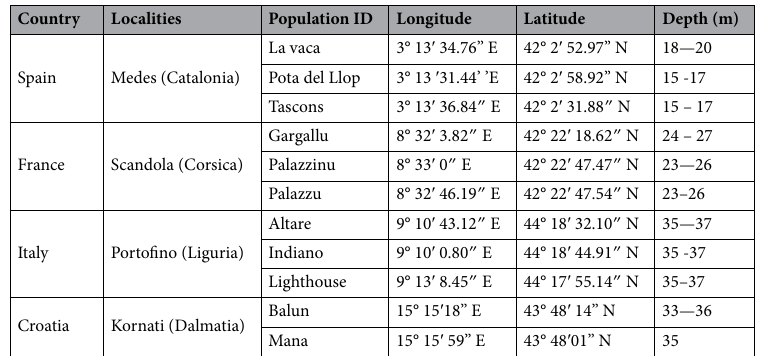
Table 1. Detailed information on the sampled populations; country, location, ID, coordinates and sampling